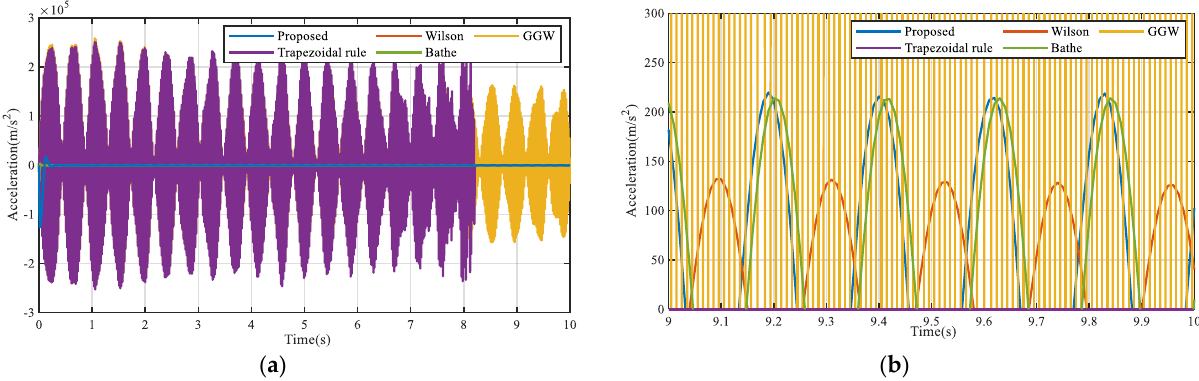
Figure 14. Velocity responses of Point A with the Wilson method, Bathe method, GGW method, trapezoidal rule, and the proposed method: ( a ) responses from 0 to 10 s; ( b ) partial enlarged drawing of responses from 9 to 10 s.